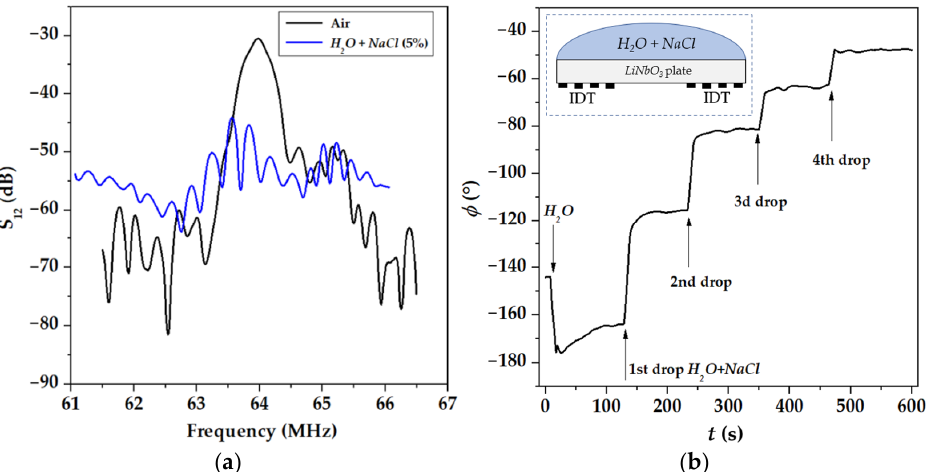
Figure 4. Insertion loss S 12 ( a ) and phase ϕ ( b ) measured for AIR (without liquid) and conductive liquids ( H 2 O + NaCl (5%)) with σ from 0 to 6 S/m deposited over the whole propagation path (30 mm). Plate: 128°YX- LiNbO 3 , h = 500 μm. Mode f = 63.9 MHz, λ = 200 μm. Test liquids: distilled water H 2 O (200 mg) and distilled water (200 mg) with drops of 0.9% NaCl (40 mg) in the water (arrows).